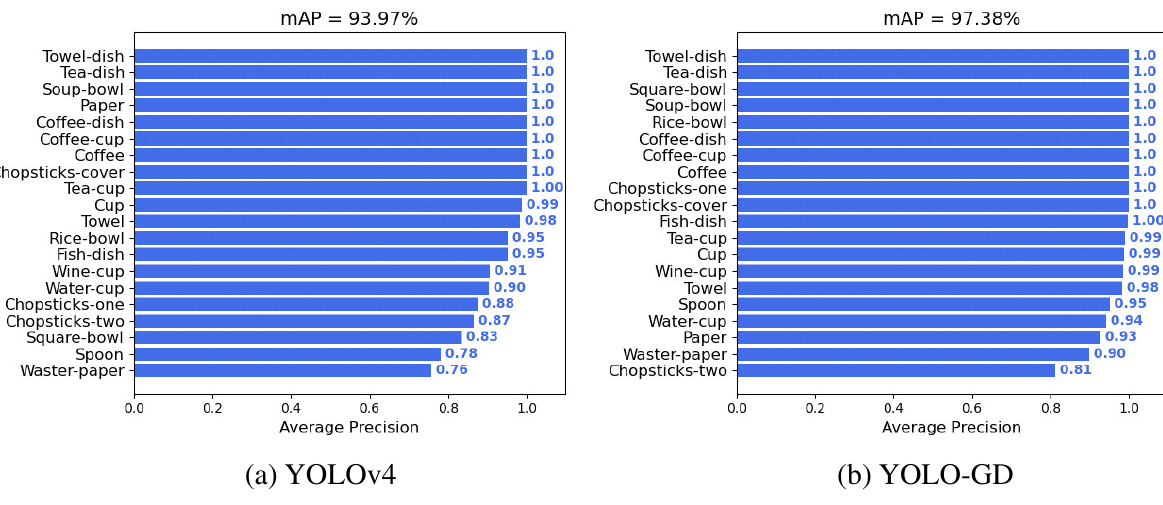
Figure 7. AP and mAP of YOLOv4 and YOLO-GD. ( a ) Is the detection result of YOLOv4 and ( b ) is the detection result of